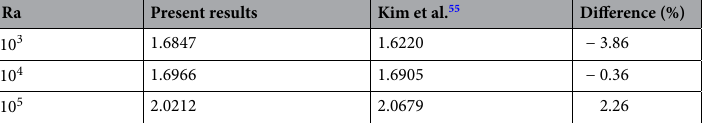
Table 3. Comparison of the surface-averaged Nusselt number at the side wall for the different values of 0.71 Pr =